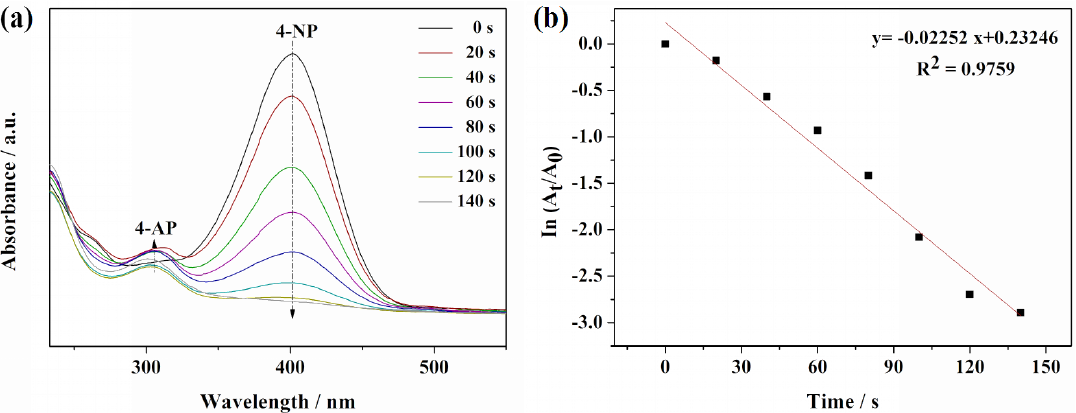
Figure 9. UV-Vis absorption spectra: ( a ) reduction of 4-NP by NaBH 4 using Ag nanorod aggregates as catalyst; ( b ) The plot of ln( A t / A 0 ) against the reaction time for pseudo-first-order reduction kinetics of 4-NP in the presence of ball-like Ag nanorod aggregates.